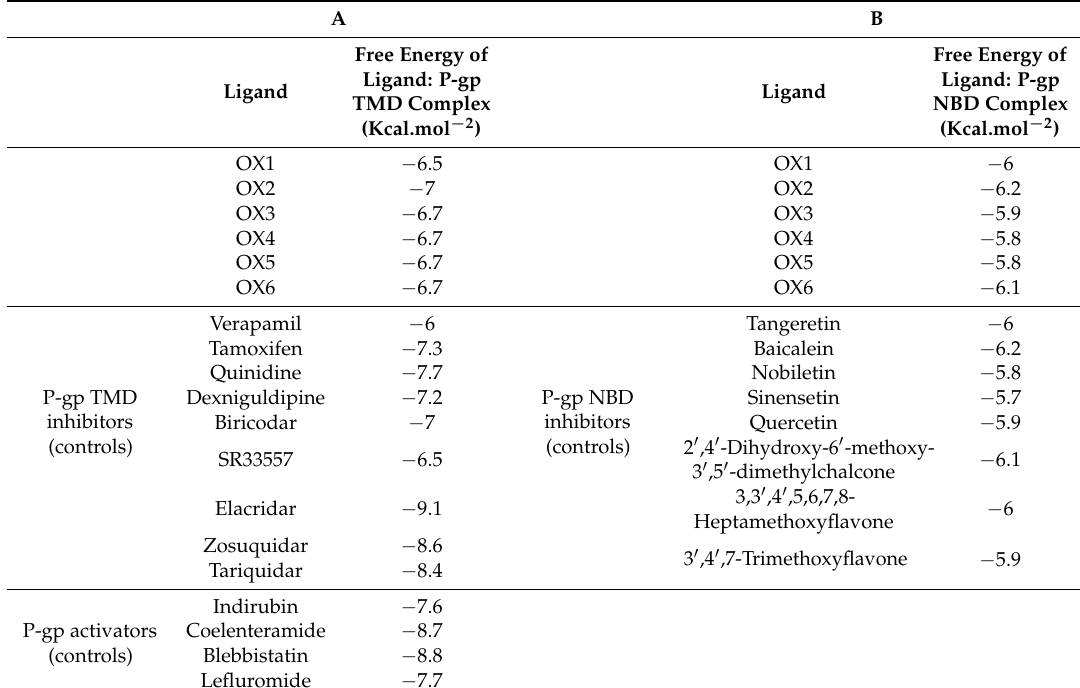
Table 3. Docking scores for the six tested oxygenated xanthones (OX 1–6) and controls on P-glycoprotein (P-gp) transmembrane domains (TMD, A) and nucleotide binding domains (NBD,